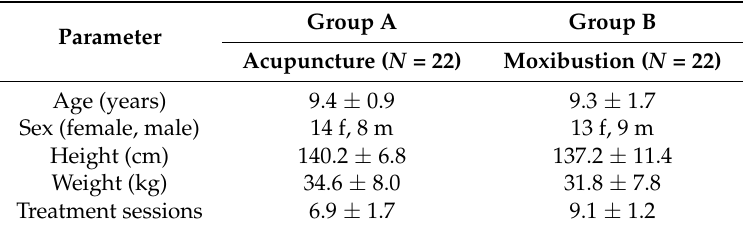
Table 1. Demographic data of the 44